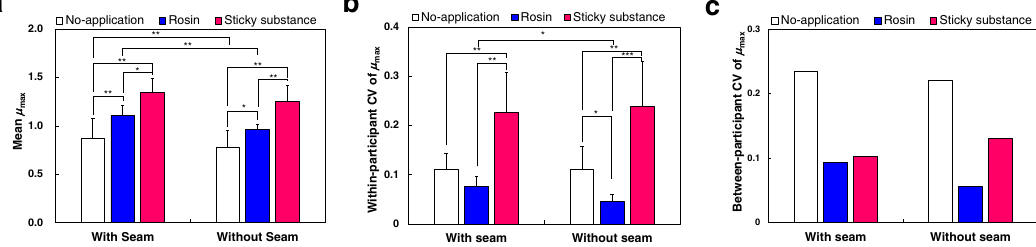
Fig. 3 Comparison of mean and CV values of friction coef fi cient for MLB ball among application conditions. a Mean µ max value under each application condition for MLB ball. b CV values of µ max within participants under each application condition for MLB ball. c CV values of mean µ max between participants under each application condition for MLB ball. The error bar indicates the standard deviation. * p < 0.05, ** p < 0.01, *** p <